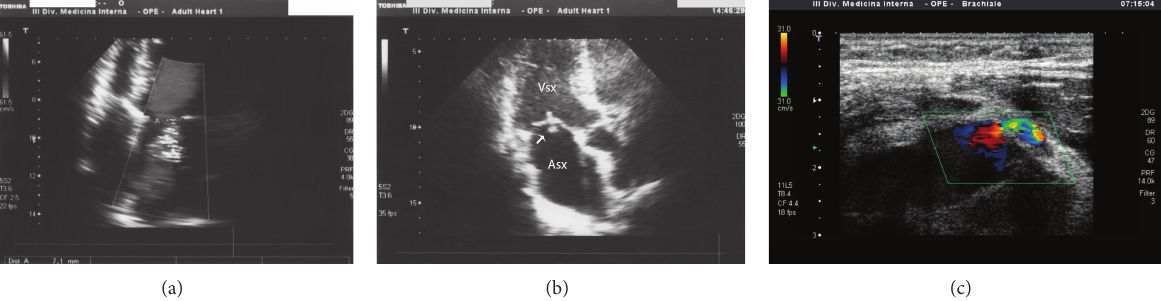
Figure 1: (a) Color Doppler imaging showing mild-to-moderate mitral regurgitation; (b) three-chamber apical view showing vegetation on distal third of mitral anterior leaflet; (c) echography of anterior aspect of right forearm showing color Doppler imaging of radial artery refueling perivascular blood collection.